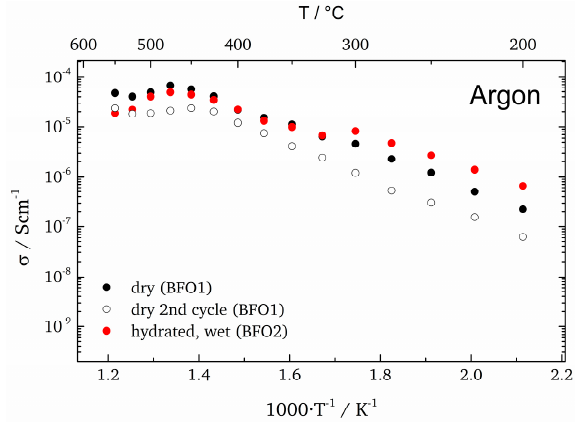
Figure 10. Arrhenius plots (only bulk contribution) for samples measured in dry/wet Ar during heating.